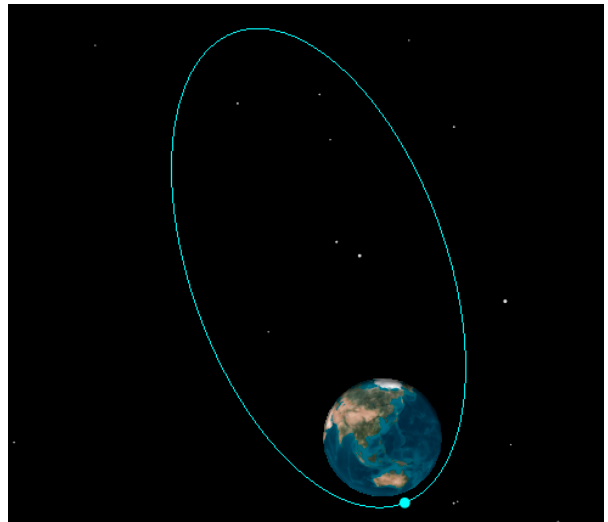
Figure 7. HEO in the three-dimensional (3D) graphic view.